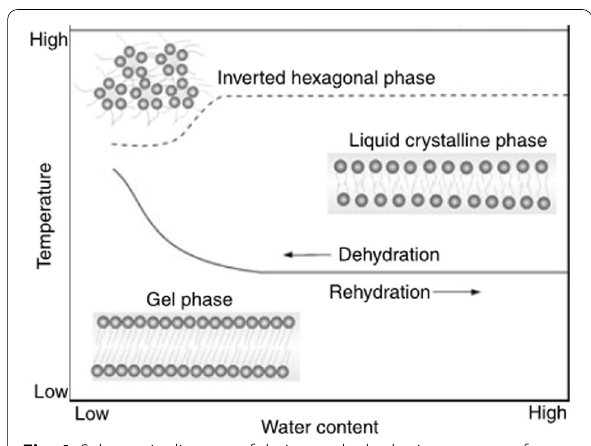
Fig. 4 Schematic diagram of drying and rehydration process of phospholipids